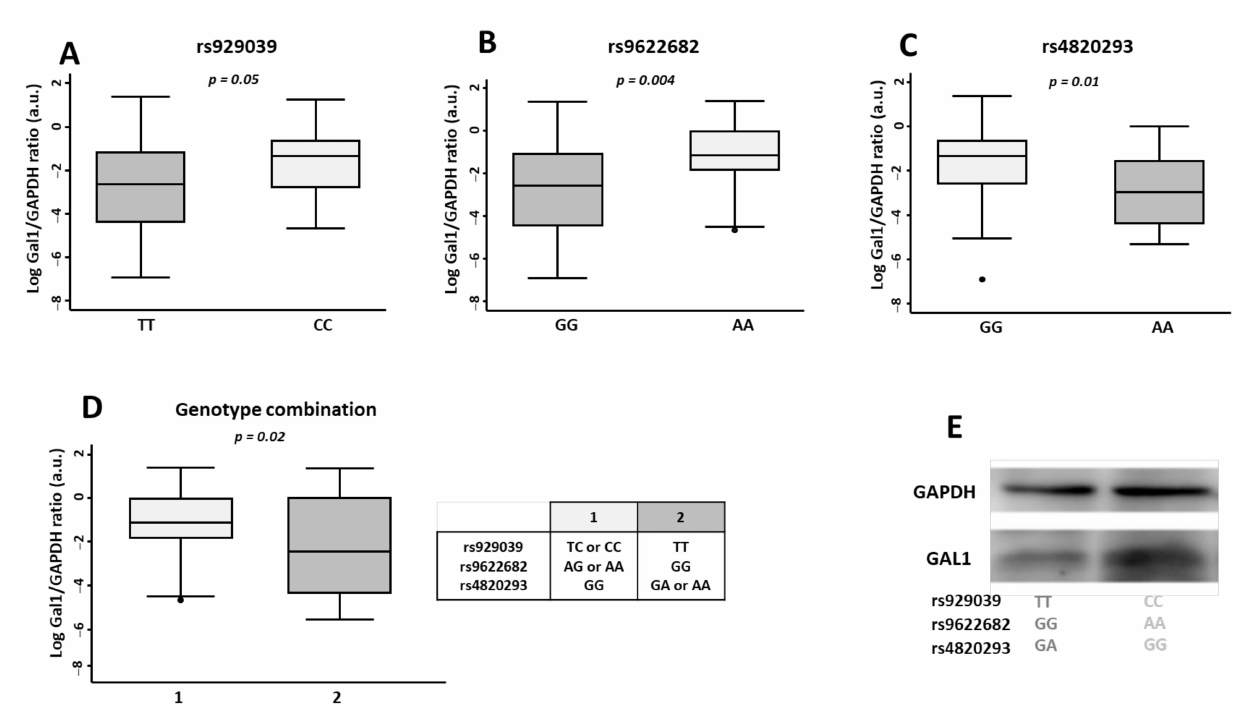
Figure 2. Effect of homozygous genotypes from LGALS1 SNPs rs929039, rs9622682, and rs4820293 in protein expression from lymphocytes assessed by western blot. Densitometric quantification of galectin 1 (Gal1) protein expression normalised to GAPDH expression in 47 early arthritis patients from the PEARL study according to homozygous genotype from de genetics variants rs929039 ( A ), rs9622682 ( B ), rs4820293 ( C ), and genotypes combination ( D ). Data are shown as interquartile range (p75 upper edge of the box, p25 lower edge, p50 midline) as well as the p95 (line above box) and p5 (line below). Dots represent outliers. Statistical significance was determined with the t-student test. The significance threshold was set at p < 0.05. ( E ) Representative blot from Gal1 expression in EA patient’s